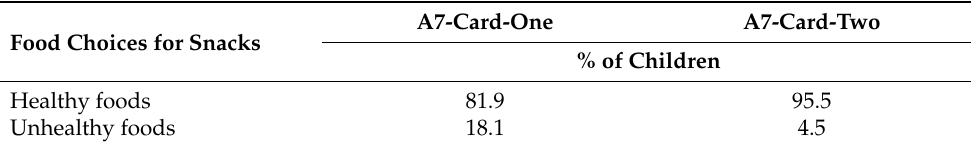
Table 7. Frequency distribution of children’s healthy food choices for snacks (A7). Food Choices for Snacks Healthy